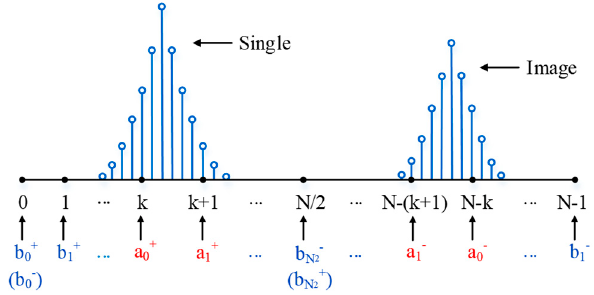
Figure 6. C orrection signal classification diagram. Figure 6. Correction signal classification